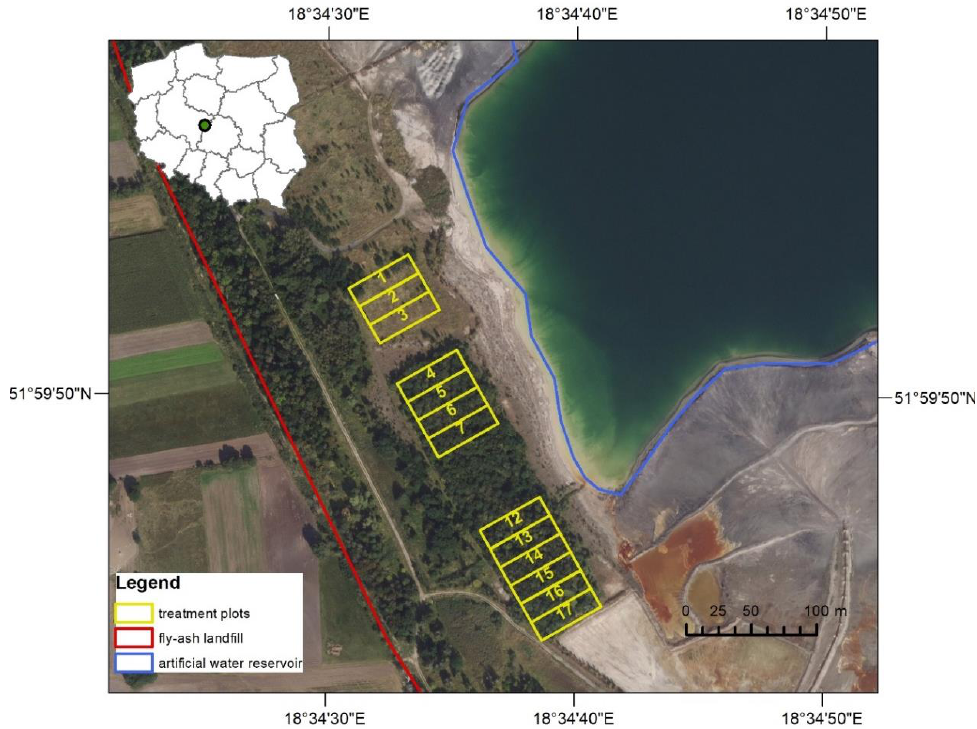
Figure 1. Location of the experimental site within the ash landfill on the background of orthopho- tomap (http://mapy.geoportal.gov.pl), accessed on 20 January 2023. Table 1. Characteristics of the plots established within the experimental site.